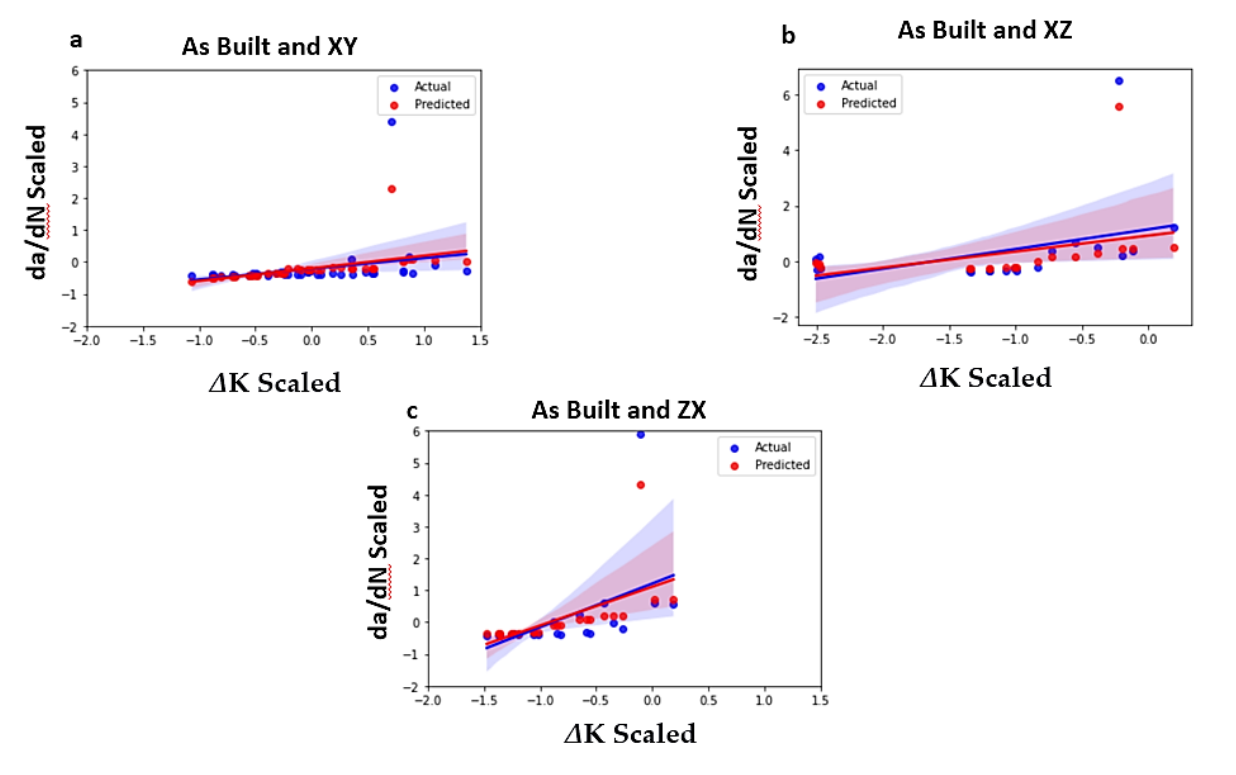
Figure 3. Actual and Prediction Plots for as Built Ti-64 alloy Samples. ( a ) XY Specimen Orientation; ( b ) XZ Specimen Orientation and ( c ) ZX Specimen Orientation.